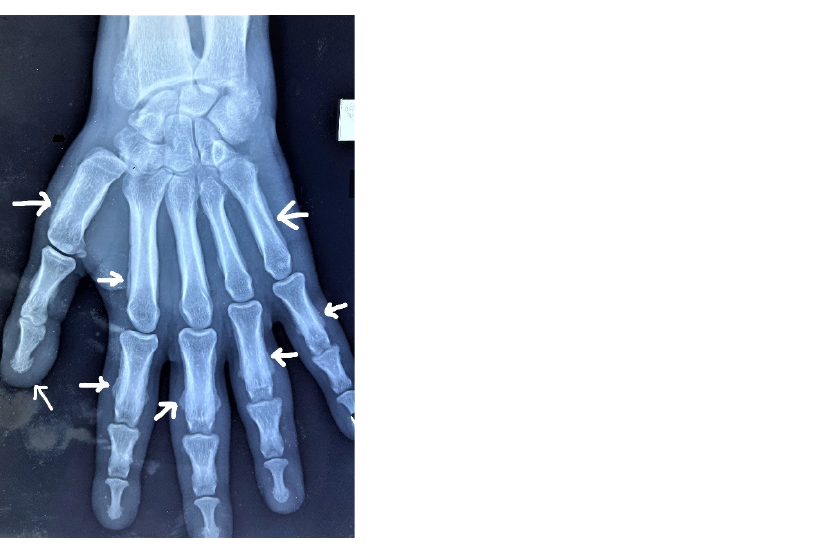
Figure 4. X-ray of hand (2014) showing irregular periosteal hypertrophy with soft tissue swelling and new bone formations affecting metacarpal bones and phalanges. New bone formation and soft tissue swelling are marked with arrows.